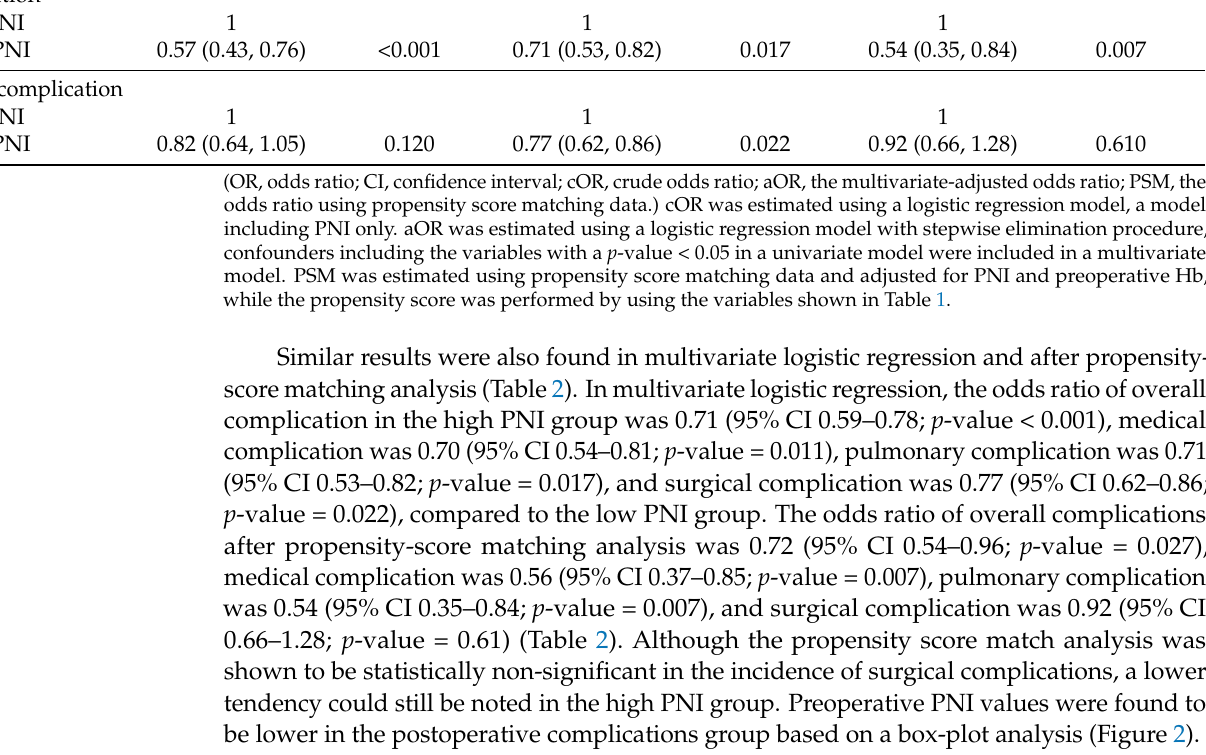
Propensity Score Match